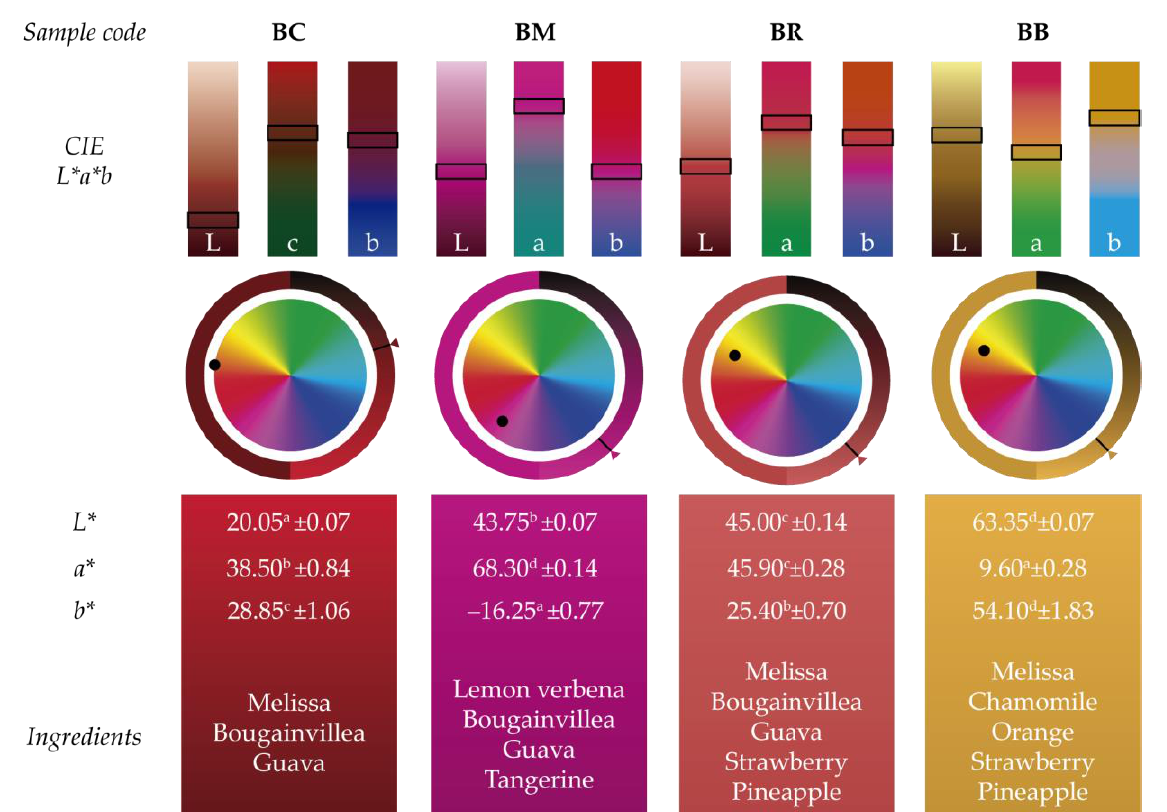
Figure 1. Color values (L* a* and b*) of the developed beverages. Mean ± Standard deviation, n = 3. Different lowercase letters within rows indicate significant difference ( p ≤ 0.05) according Duncan’s test.